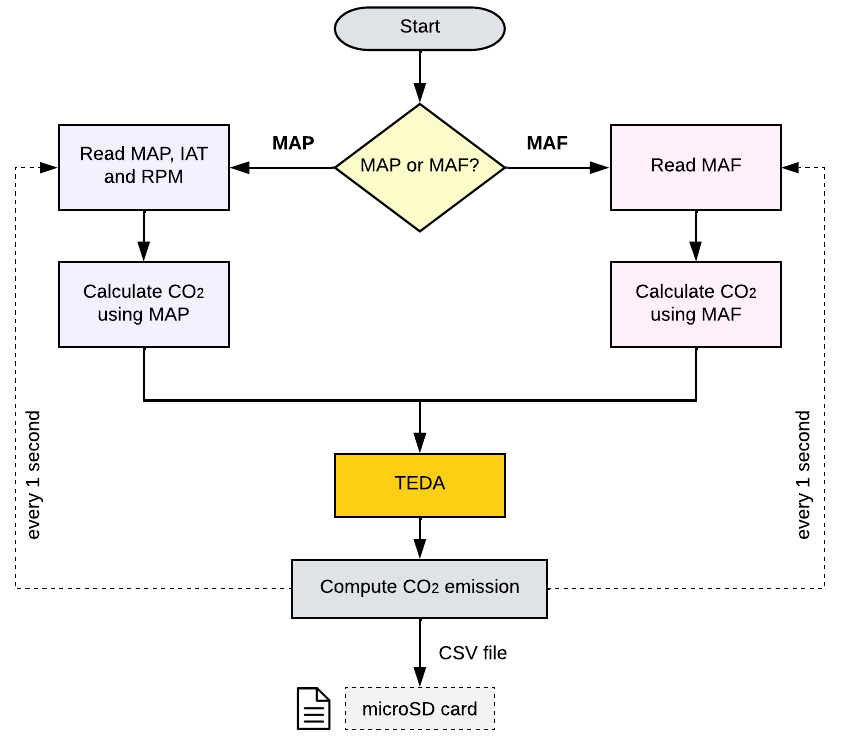
Figure 2. The processing flow of the proposed soft-sensor